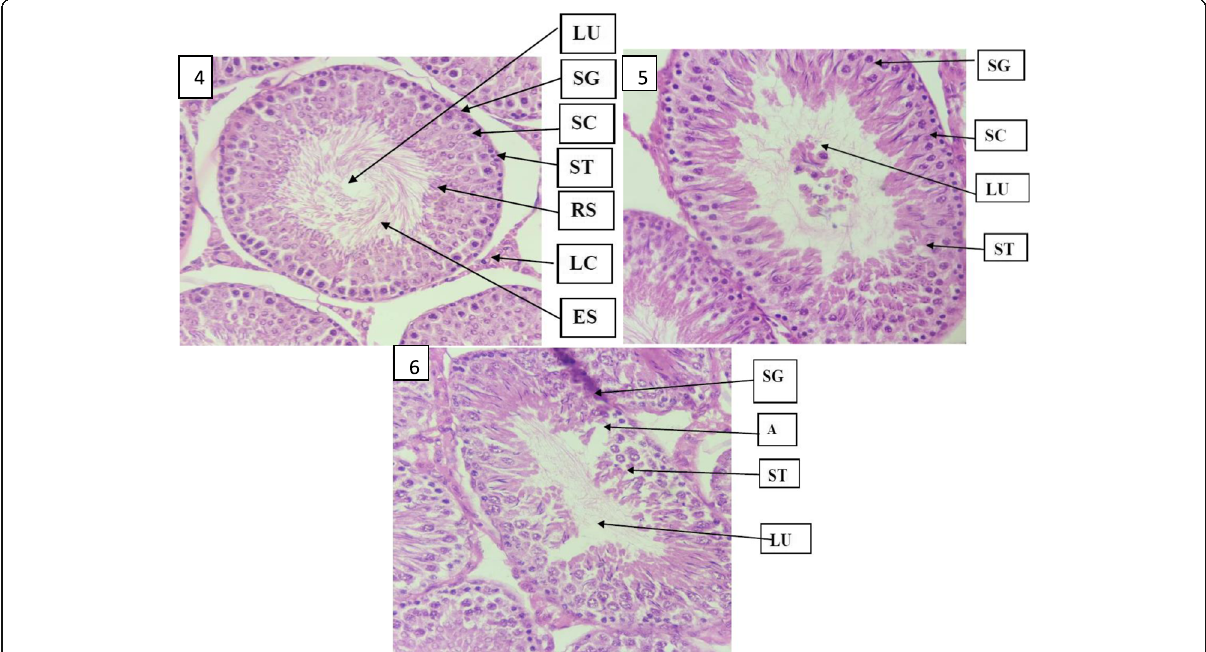
Fig. 7 Photomicrograph of histological sections of the testes of the experimental rats at week 6. H & E × 400. Plate 4: Control subgroup (1b). Interstitial cells of Leydig in the interstitial space (LC); Seminiferous tubule epithelium containing cells of the spermatogenic series including spermatogonia (SZ); spermatocyte (SC); Round spermatids (RS); elongated spermatids (ES) and sertoli cells and the lumen containing spermatozoa(LU). Plate 5: Treated subgroup (2b) with 250 mg/kg body weight of aqueous root extract of Chrysophyllum albidum. Spermatogenic arrest at the stage of conversion from spermatocyte to spermatids. Spermatogenic cells in view include spermatogonia (SG); spermatocyte (SC). The lumen contains admixture of immature cells of the spermatogenic series (LU). Plate 6: Treated subgroup (3b) with 500 mg/kg body weight of aqueous root extract of Chrysophyllum albidum . Sectioned area showing Focal Spermatogenic arrest